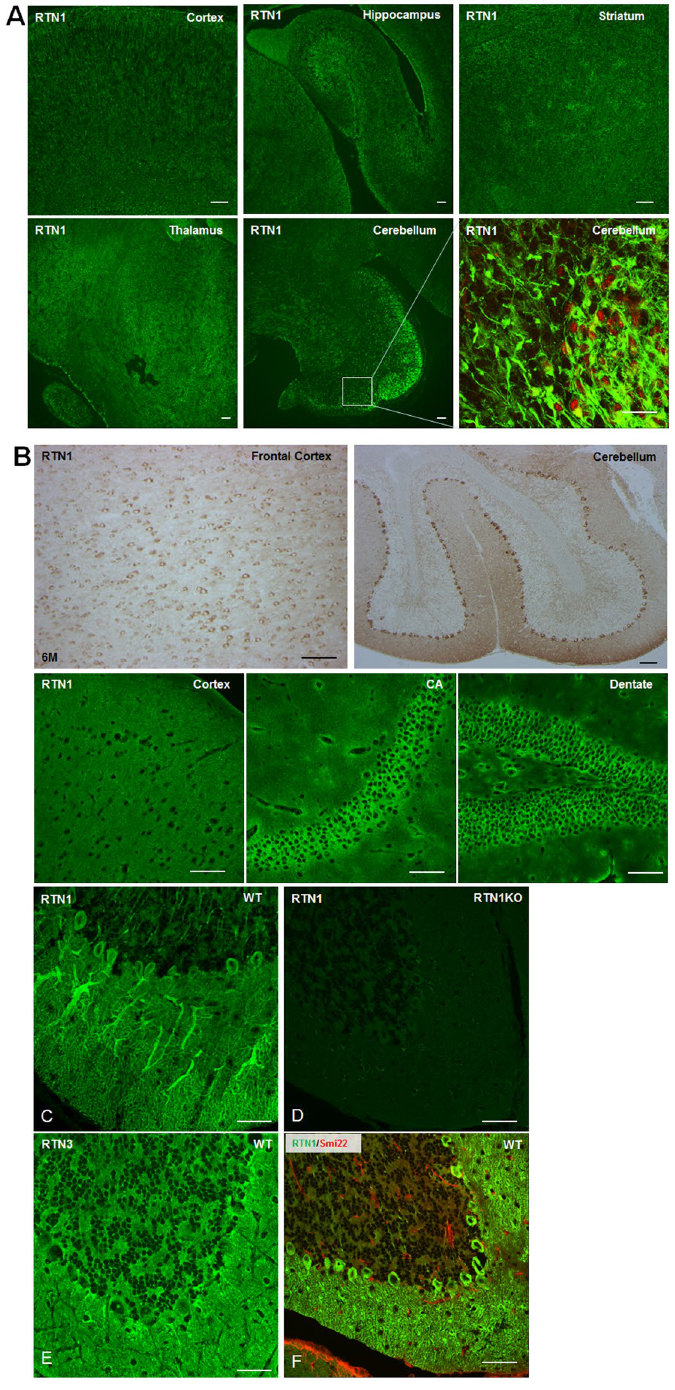
Figure 3. RTN1 is a neuronal protein. ( A , B ) Confocal and immunohistochemical staining of RTN1 in brain sections from postnatal day 0 ( A ) and at six months of age ( B ) were performed with antibody R418. RTN1 is clearly expressed in neurons in broad brain regions including the frontal cortex, cerebellum, and hippocampal CA and dentate gyrus. ( C – E ) Confocal results showed strong expression of RTN1 in Purkinje cells and dendrites by R418 staining ( C ), which was not seen in RTN1-null brain sections ( D ). RTN3 labels neurons, including Purkinje cells, but dendrites of Purkinje cells were not highlighted by RTN3 antibody ( E ). ( F ) Co- staining of RTN1 antibody (green) and Smil22 (red) were conducted to label astrocytes. Scale bar is 50 µ